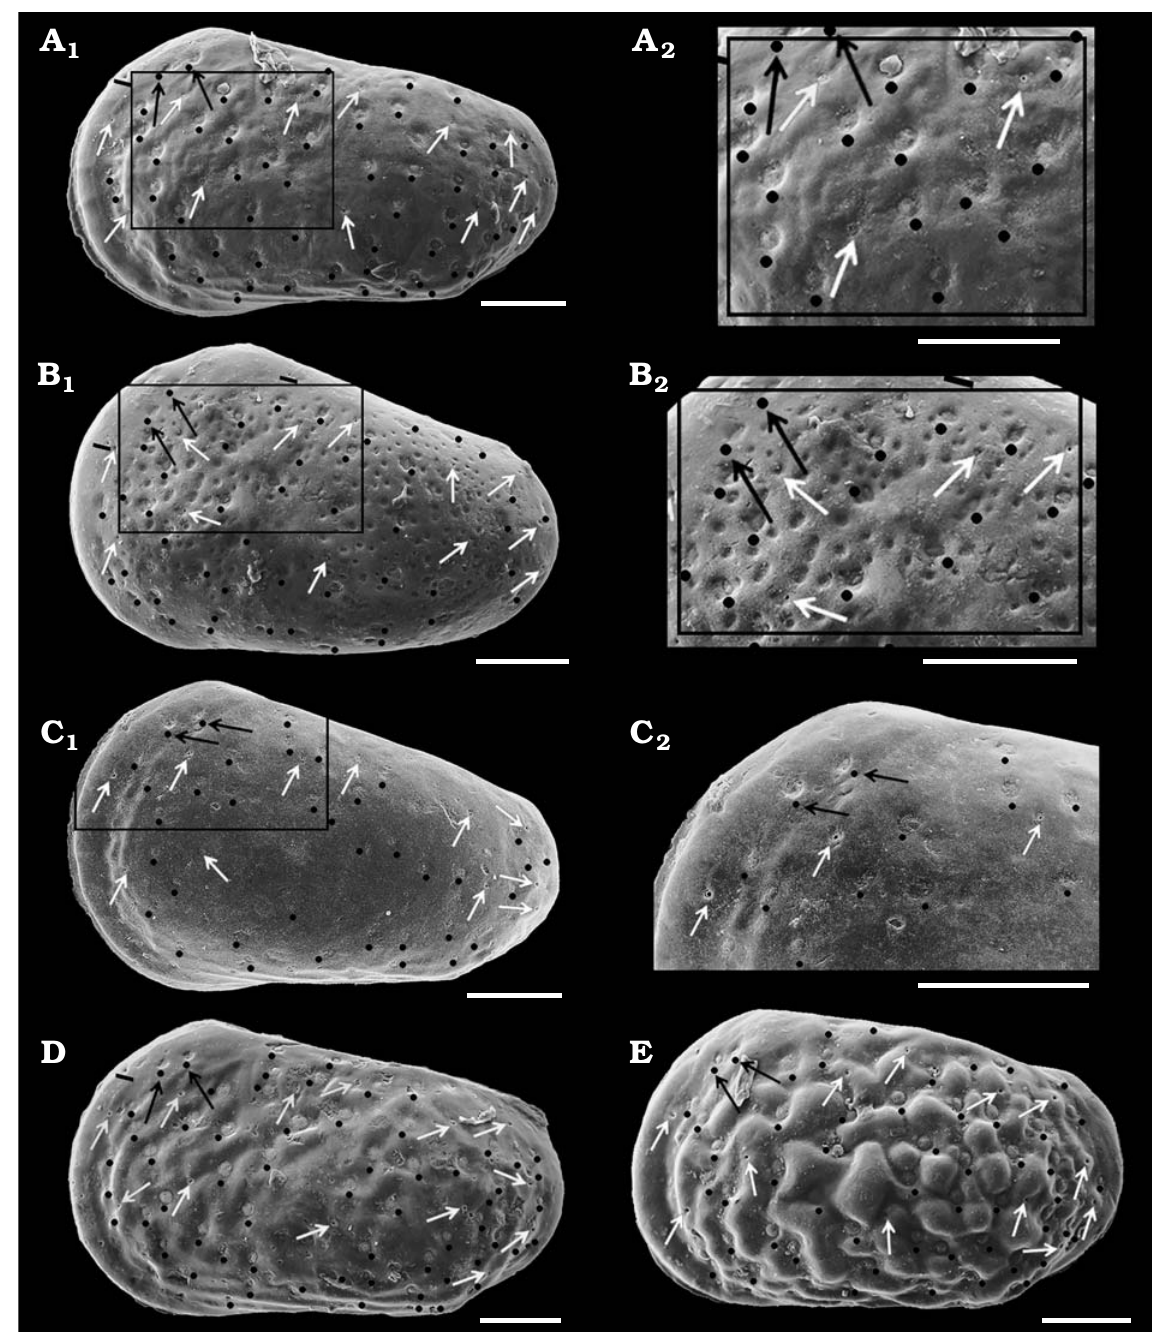
Fig. 6. Distribution of sieve-type normal pore canals (StPC) and simple normal pore canals (NPC) on the outer side of left valves of cytherid ostracod Minyocythere gen. et spp. nov. A . Minyocythere macroporosa sp. nov. from Borehole Hambühren WA2, 166 m, NW Germany, Witchellia laeviuscula Zone (Braun Jura γ ), Lower Bajocian. Holotype, SMF Xe 23721, male left valve (A 1 ), detail (A 2 ), total area of A 2 , c. 45 μ m 2 . B . Minyocythere angulata sp. nov. from Borehole Hambühren WA2, 203 m, NW Germany, Upper Aalenian (Braun Jura β ). Holotype, SMF Xe 23737, male left valve (B 1 ), detail (B 2 ), total area of B 2 , c. 44 μ m 2 . C . Minyocythere sp. cf. M . macroporosa sp. nov. from Borehole Rodewald WA12, 404.5 m, NW Germany, Witchellia laeviuscula Zone (Braun Jura γ upper), Lower Bajocian. SMF Xe 23725, male left valve (C 1 ), detail (C 2 ). D . Minyocythere maculosa (Bate, 1963) from Hambühren WA2, 171–174 m, NW Germany, Upper Aalenian (Braun Jura β ). SMF Xe 23750, male left valve. E . Minyocythere tuberculata (Luppold, 2012) from Borehole Rodewald WA12, 404.5 m, NW Germany, Witchellia laeviuscula Zone (Braun Jura γ upper), Lower Bajocian. SMF Xe 23754, female left valve. Black dots refer to macro StPC (StPC-M); white arrows point to micro StPC (StPC-m); simple NPC underlined; black arrows indicate position of the two StPC-M characteristic of Minyocythere species. Scale bars 100 μ of tubuli visible about 20 in 2–3 rows. Number StPC-m Interior : Marginal zone well developed anteriorly, inner counted 12, much fewer than StPC-M. margin and line of concrescence coincide; marginal pore